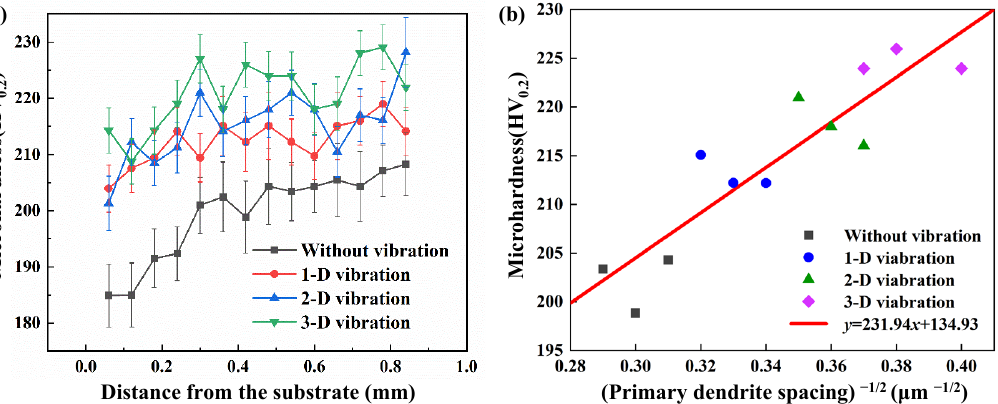
Figure 7. Microhardness distribution and the relationship between the microhardness and the primary dendrite spacing: ( a ) microhardness distribution along the build direction of the laser cladding layer with and without vibration; ( b ) the relationship between the microhardness and the primary dendrite spacing.